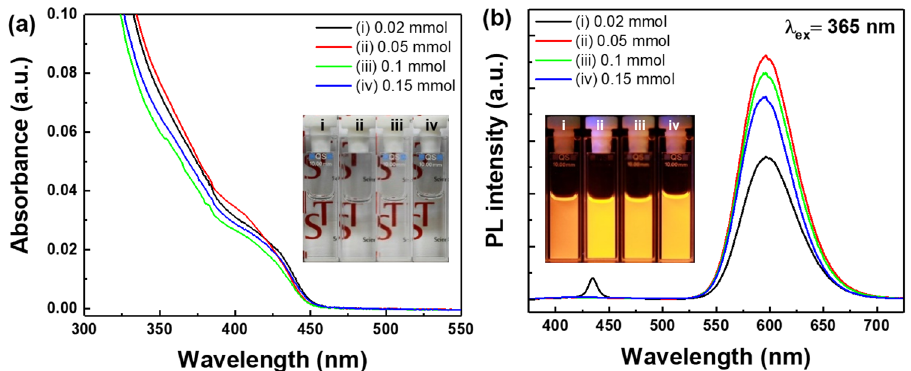
Figure 2. ( a ) Absorption and ( b ) PL spectra of the as-synthesized ZnSe:Mn 2+ /ZnS d-C/S QDs synthesized with various amounts of Mn-oleate (i: 0.02 mmol, ii: 0.05 mmol, iii: 0.1 mmol, and iv: 0.15 mmol). Insets in ( a ) and ( b ) show photographs of the ZnSe:Mn 2+ /ZnS d-C/S QD solutions under indoor light and UV light (λ ex = 365 nm),